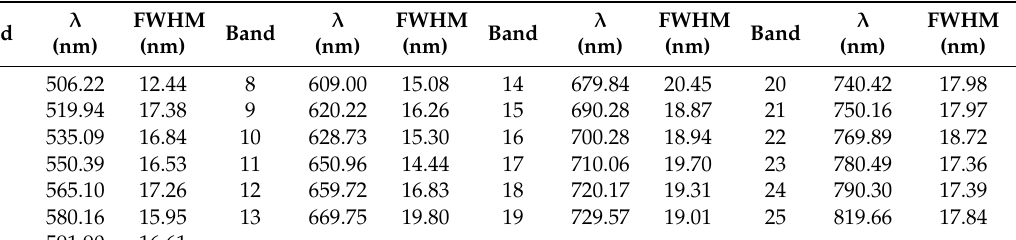
Table 3. Spectral settings of an FPI camera, model DT-0011, with the respective FWHM, both in nm (λ represents the central wavelength of the band).